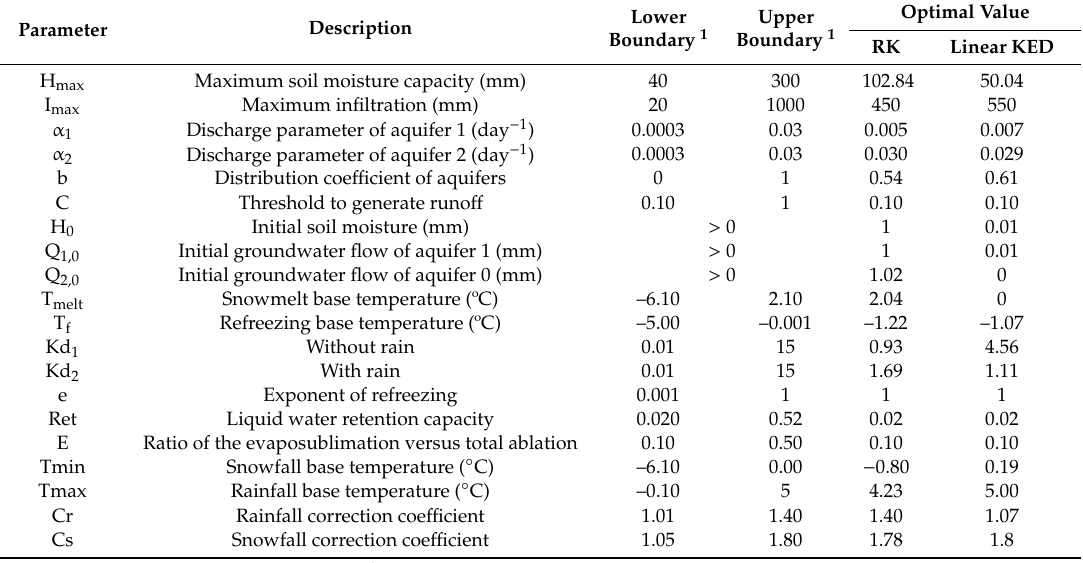
Table 4. Calibrated parameters of the STM using RK and linear KED climatic fields. Parameter